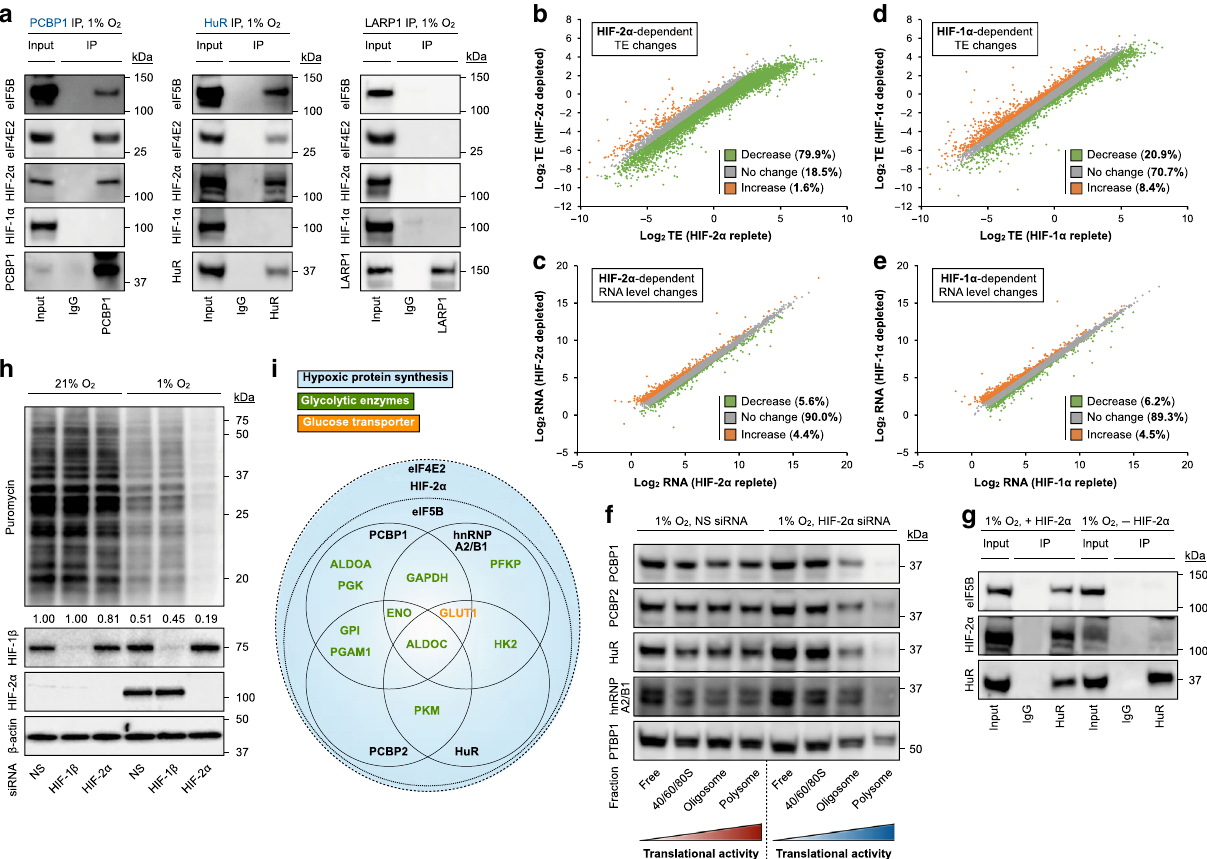
Fig. 5 Oxygen-sensitive RBPs collaborate with the hypoxic protein synthesis machinery. a Representative immunoblots of HuR, PCBP1 (hypoxia- adaptive, blue), and LARP1 (non-hypoxia-activated, black) co-immunoprecipitations in U87MG. Three independent experiments ( n = 3) were performed with similar results. Global RNA sequencing analysis of ( b , c ) HIF-2 α - and ( d , e ) HIF-1 α -dependent changes in ( b , d ) translation ef fi ciency (TE) and ( c , e ) steady-state mRNA levels. f Representative immunoblots of hypoxia-adaptive RBPs in hypoxic U87MG ribosome density fractions with and without HIF-2 α siRNA-mediated knockdown (for 48 h prior to following experimentation). Color scheme: red, normoxia; blue, hypoxia. Three independent experiments ( n = 3) were performed with similar results. g Representative immunoblots of HuR co-immunoprecipitations with and without HIF-2 α siRNA-mediated knockdown in U87MG. Three independent experiments ( n = 3) were performed with similar results. h Representative immunoblots of U87MG treated